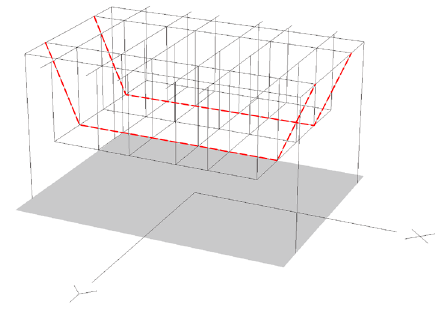
Figure 21. Analytical model in the STERA